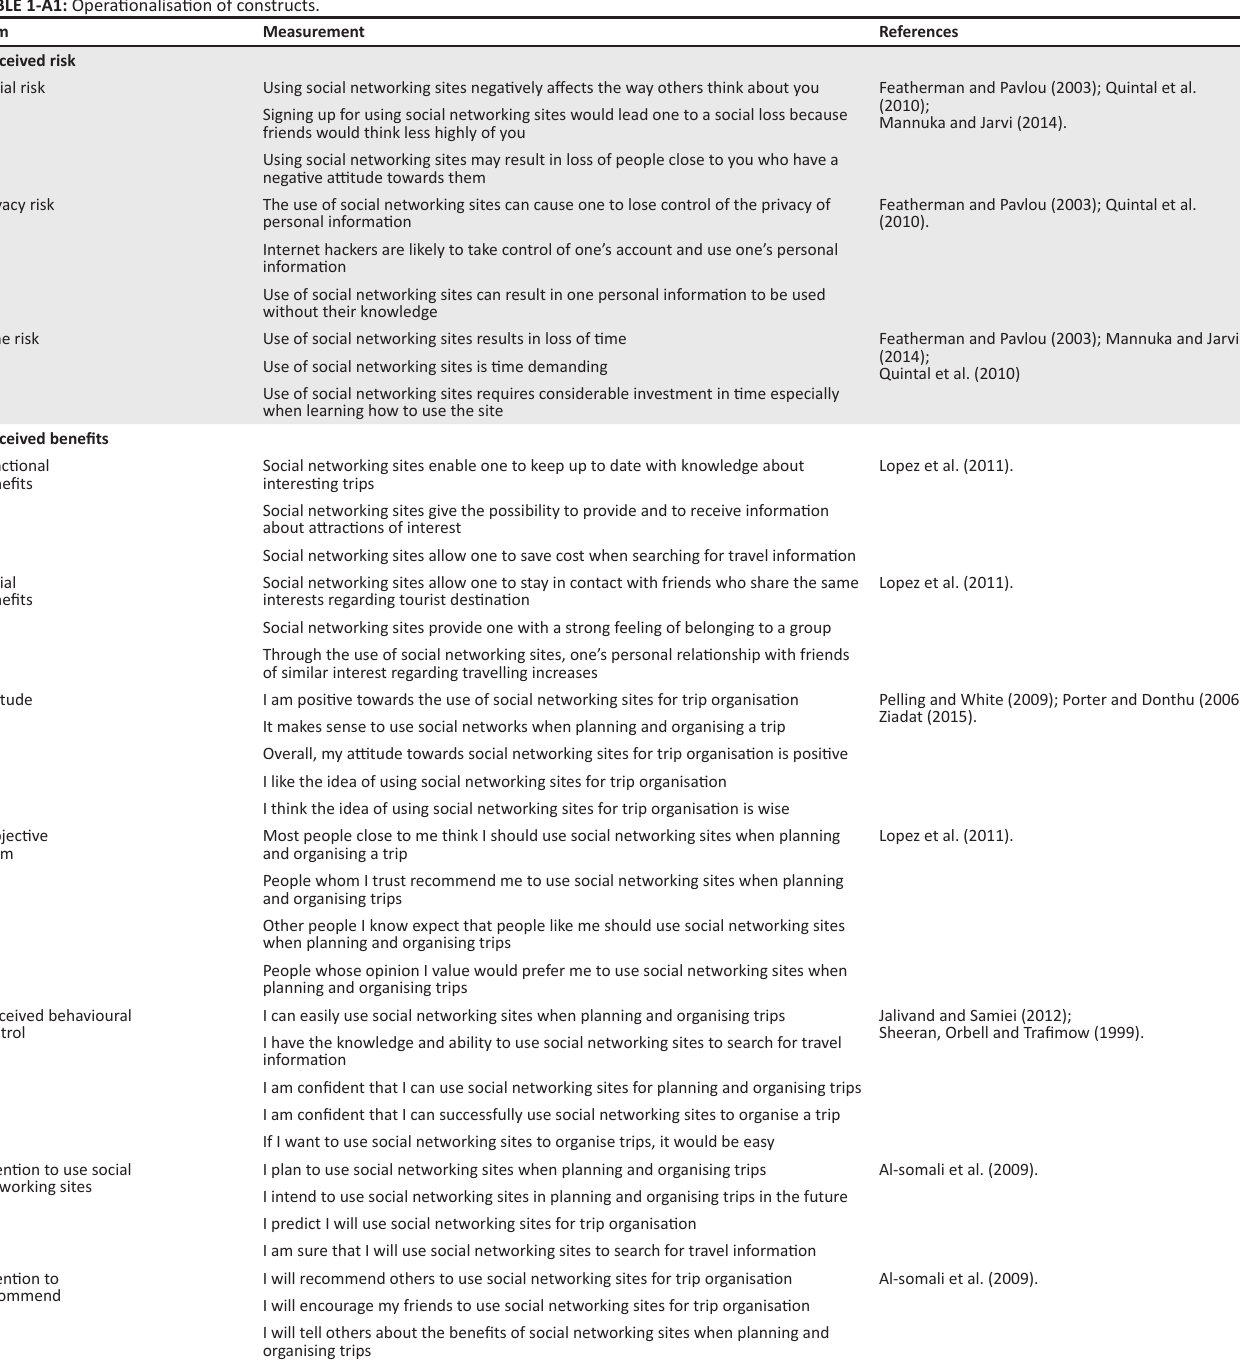
TABLE 1-A1: Operationalisation of